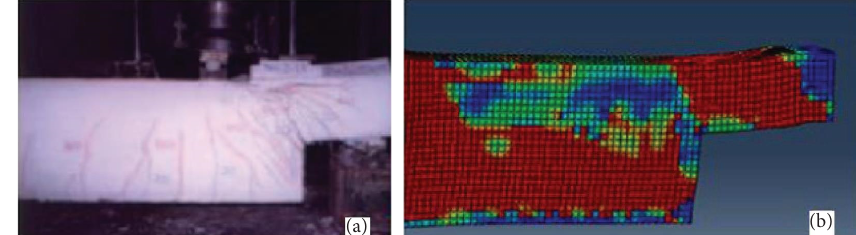
Figure 4: Failure mode of dapped-end beam (a) experimental [16] and (b) fnite